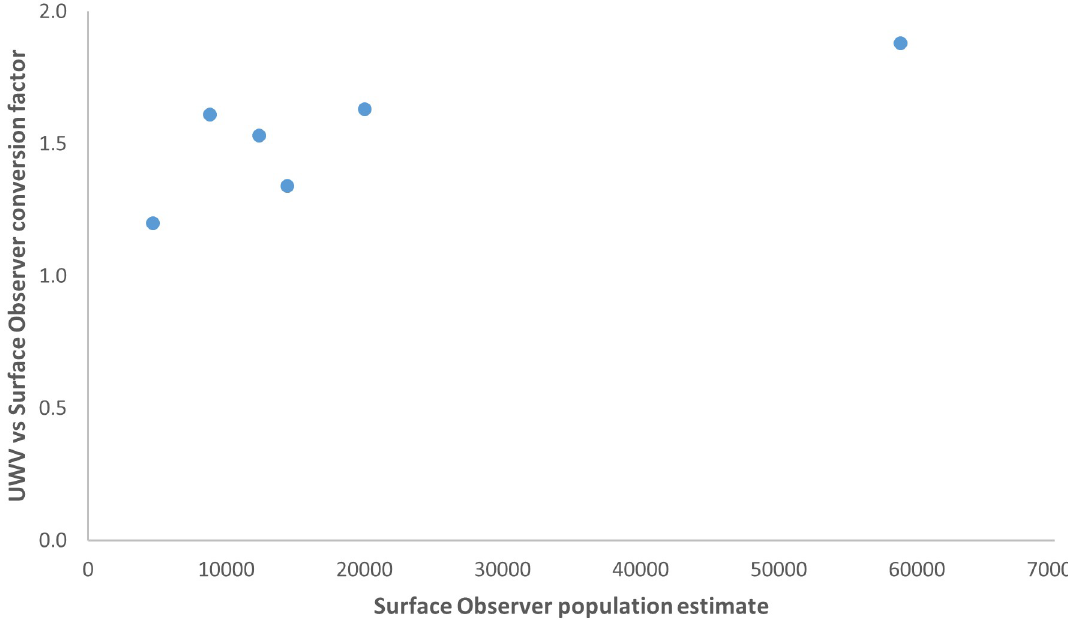
Fig 7. Conversion factor ratio of underwater video vs surface observer methods compared with population estimates from surface observer surveys from different seasons. (UVW, Underwater video).